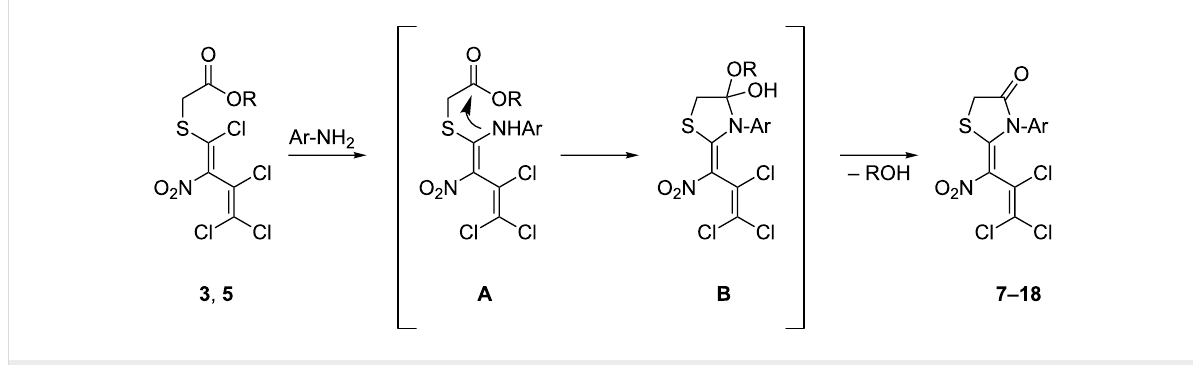
Scheme 3: Assumed mechanism for the formation of thiazolidin-4-ones 7–18 .